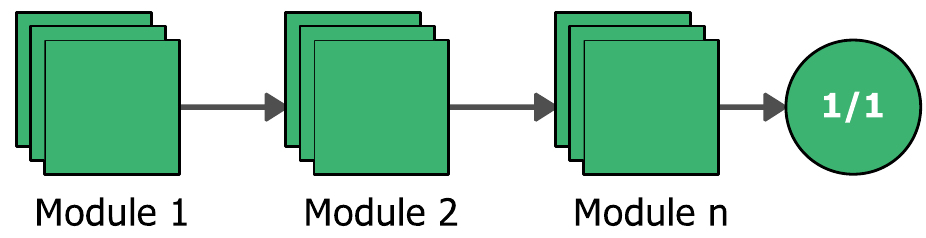
Figure 5. Reliability block diagram of vehicle energy storage (all types).